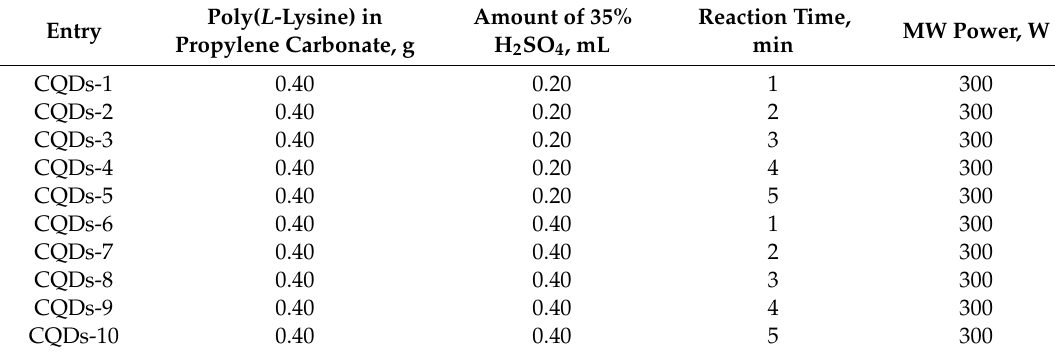
Table 1. Synthesis parameters of poly(lysine) / carbon quantum dot obtainment under MW radiation. Poly( L -Lysine) in Amount of 35% Reaction Time, Entry MW Power, W Propylene Carbonate, g H 2 SO 4 , mL min CQDs-1 0.40 0.20 1 300 CQDs-2 0.40 0.20 300 CQDs-3 0.40 0.20 300 CQDs-4 0.40 0.20 300 CQDs-5 0.40 0.20 300 CQDs-6 0.40 0.40 300 CQDs-7 0.40 0.40 CQDs-8 0.40 0.40 CQDs-9 0.40 0.40 CQDs-10